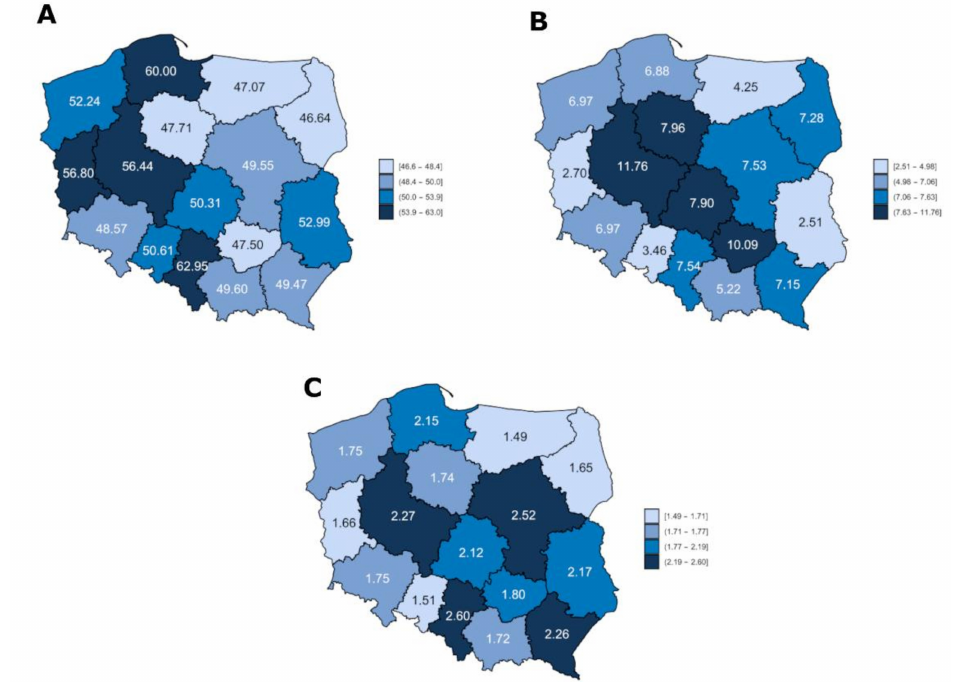
Figure 3. Prevalence of salivary gland pathologies by voivodeships in Poland in 2010–2019 per 100,000 inhabitants. ( A )—Prevalence of non-neoplastic salivary gland diseases; ( B )—Prevalence of benign salivary gland neoplasms; ( C )—Prevalence of malignant salivary gland